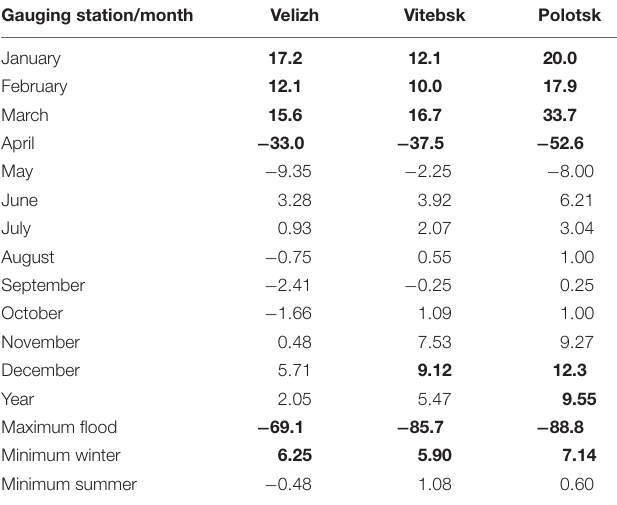
TABLE 3 | The monthly, annual, and extreme streamflow trends (m 3 s − 1 per 10 years) and their significance (estimates that are significant at the significance levels from 0.001 to 0.05 are shown in